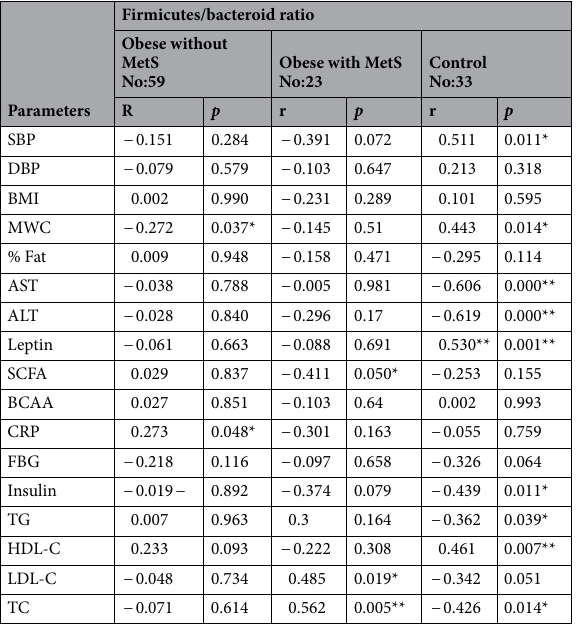
Table 6. Pearson’s correlation coefficient between Firmicutes/Bacteroid ratio and markers of MetS and other biochemical parameters of the studied sample. Significance difference * p ≤ 0.05, ** p ≤ 0.01, *** p ≤ 0.000. FBG, Fasting blood glucose; TC, Total Cholesterol; TG, Triglyceride; HDL-C, High density lipoprotein – Cholesterol LDL-C, Low density lipoprotein-Cholesterol; ALT, Alanine aminotransferase; AST, Aspartate aminotransferase; SCFA, Short chain fatty acid; CRP, C-reactive protein.